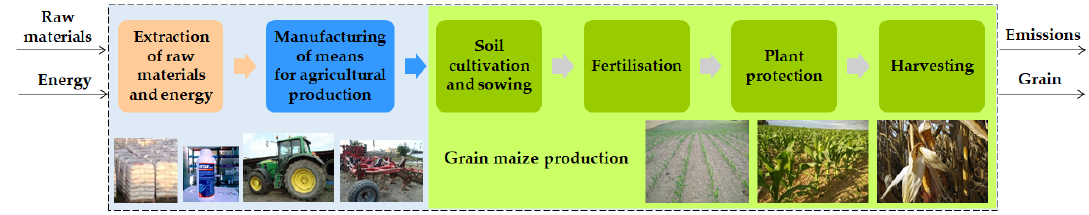
Figure 4. System boundaries of the life cycle of grain maize production from “cradle-to-farm gate”.